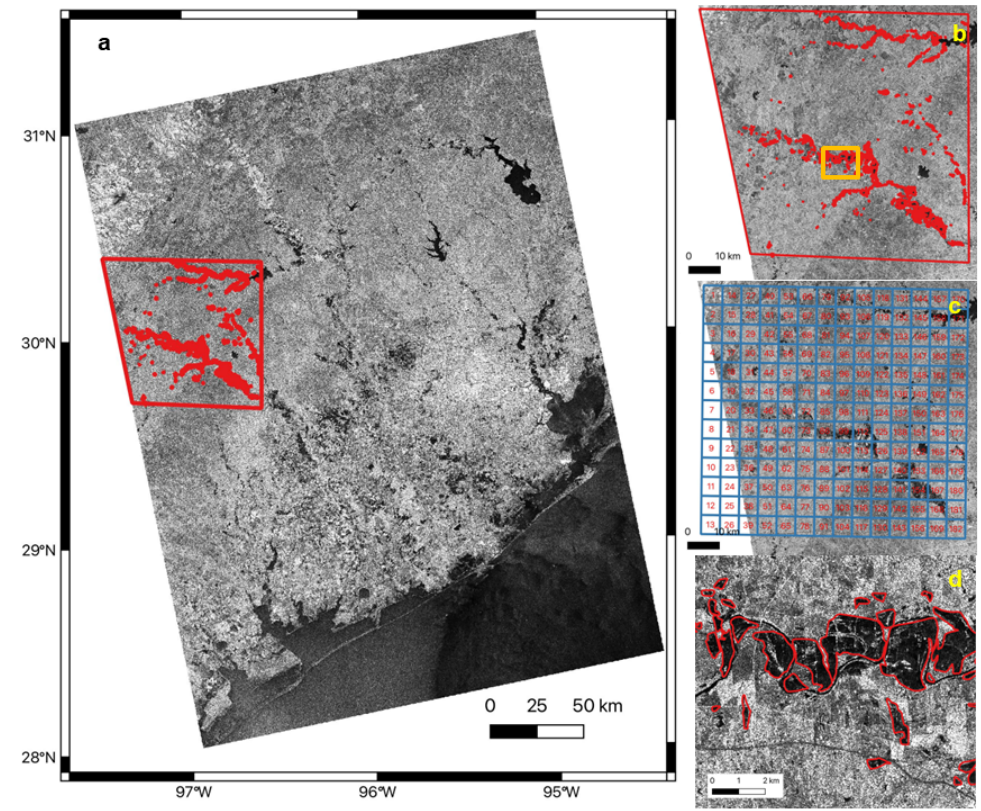
Figure 6. ( a ) SAR GRD image of Houston, TX, 29 August 2017, with training region and polygons outlined in red; ( b ) training polygons from ( a ); ( c ) grids for manually drawing flooding areas; and ( d ) enlarged training polygons marked by the orange box in ( b ). ( d ) enlarged training polygons marked by the orange box in ( b